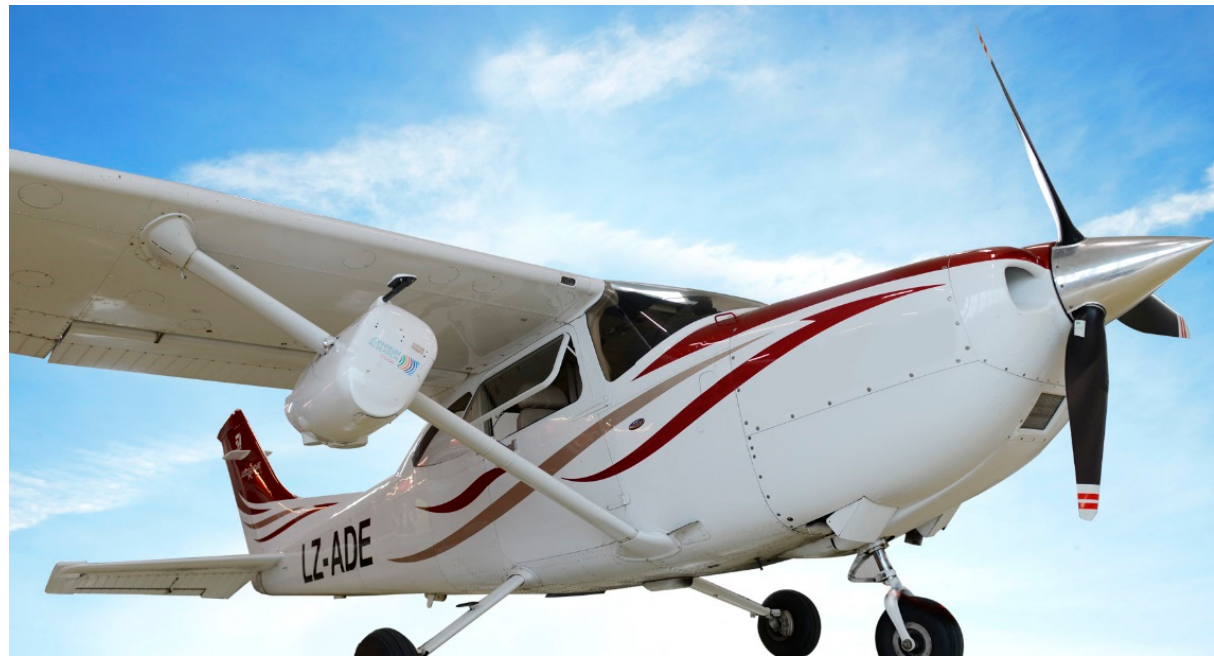
Figure 8. ADAM, aircraft platform (source: https://www.joanneum.at/en/digital/productssolutions/adam, (accessed on 4 November 2022). Table 2. Technical specifications of commonly known satellite